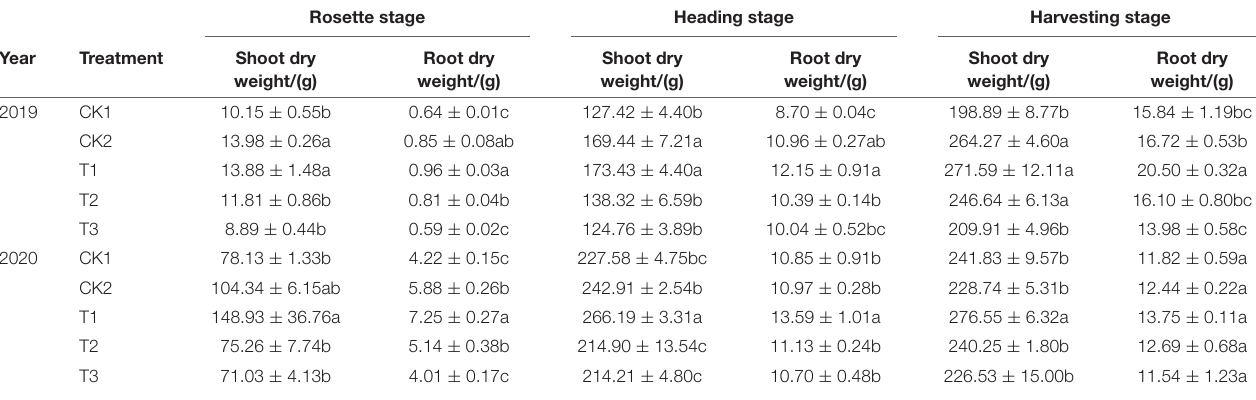
TABLE 2 | Effects of different ground mulching patterns on the dry weight of loose-curd cauliflower. Rosette stage